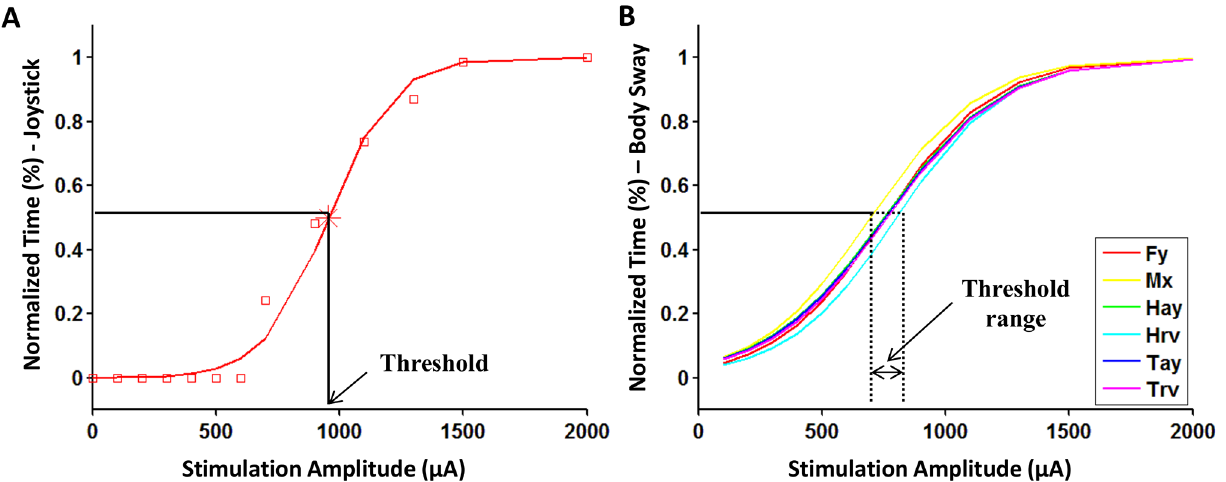
Fig 5. Nonlinear regression fitted lines of logistic psychometric function on the normalized percent time data at different stimulation amplitudes for a typical subject. (A) motion perception using Joystick data (red squares indicate normalized percent time of perceptual motion detected at each stimulation level), (B) body sway using physiological data: Fy, Mx, Hay, Hrv, Tay, Trv (individual normalized percent time data points quantified for each of the different body sway measures are not shown for clarity).